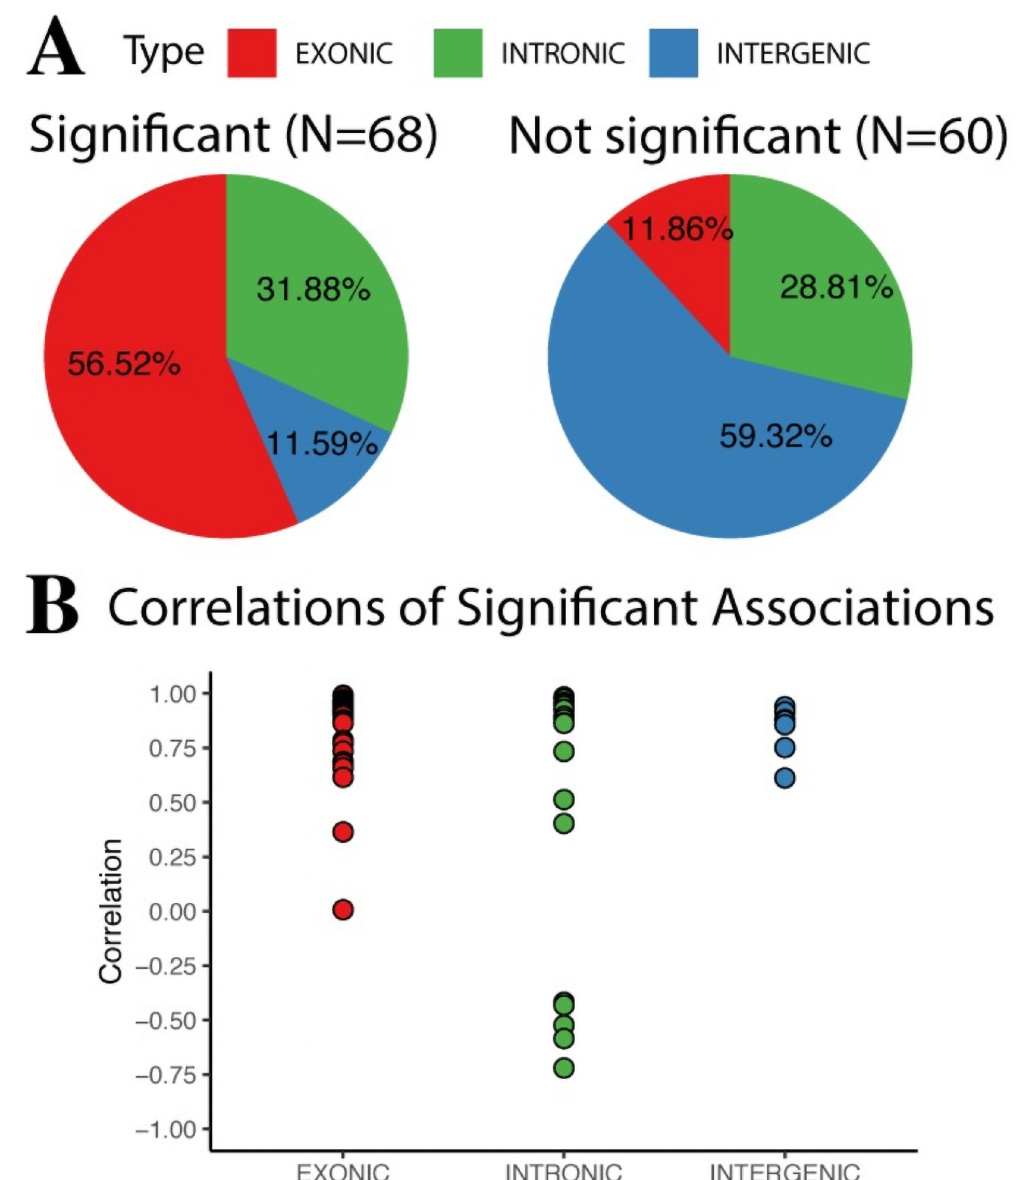
Fig 4. Gene-TE associations. (A) Pie charts depicting the distribution of gene-TE associations by locus type. (B) Dot plot showing the distribution of the Correlation coefficients of the statistically significant gene-TE associations by locus type.